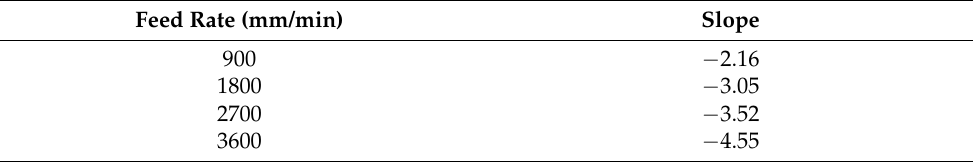
Table 4. Slope of the curve in Figure 4.